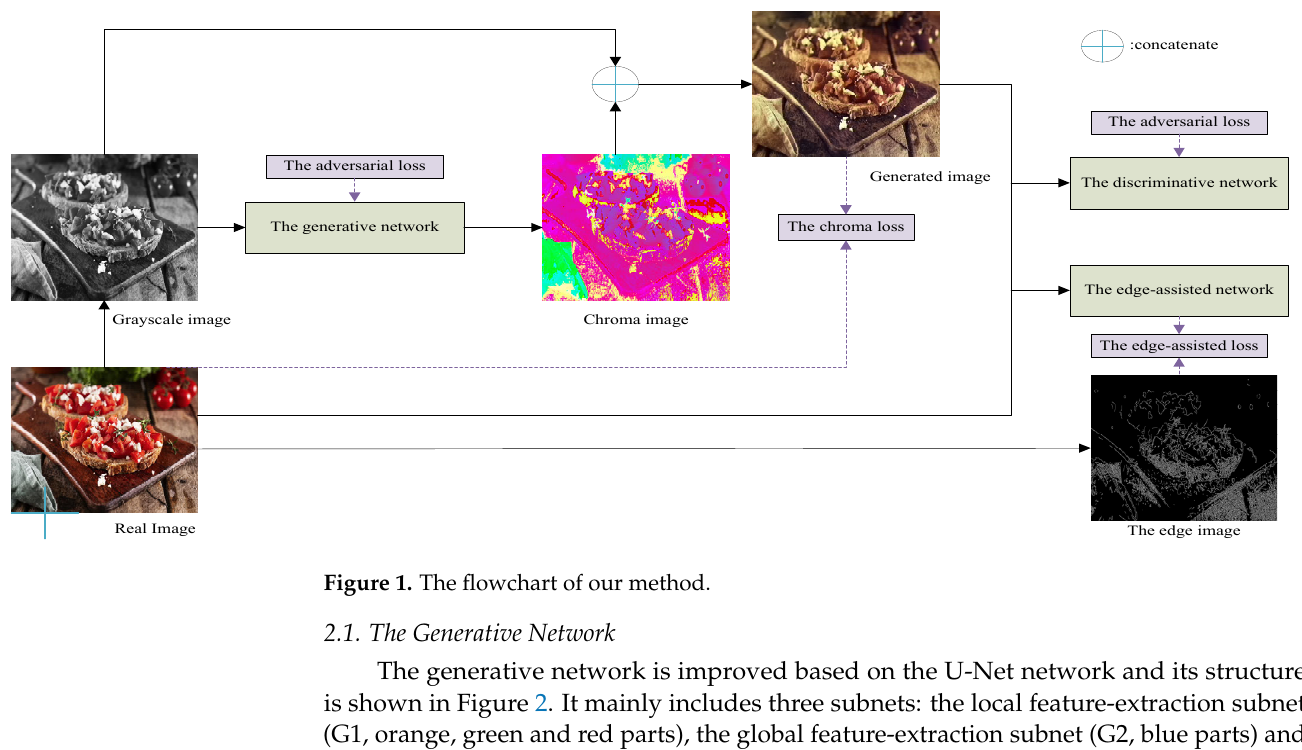
Figure 1. The flowchart of our method.